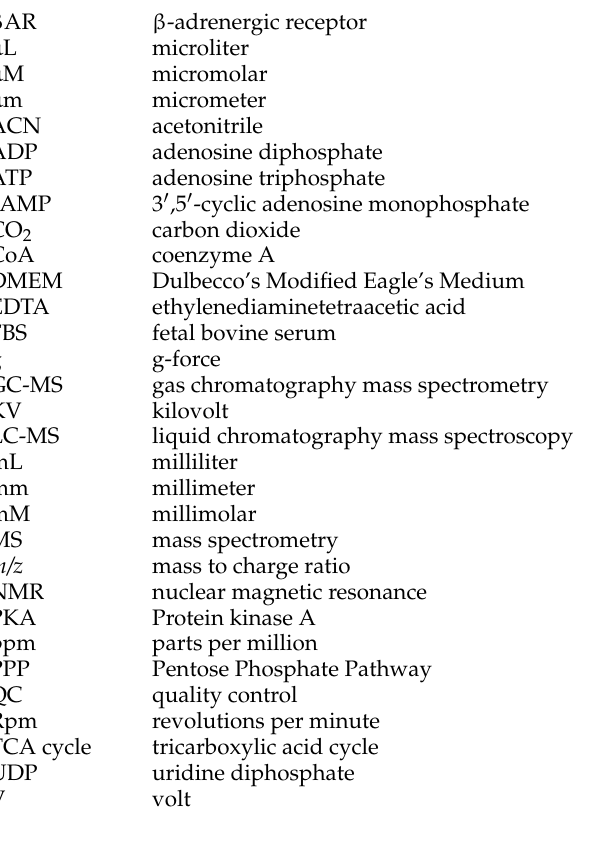
Figure S1: Principal components analysis scores plot for the first two principal components from untargeted metabolomics analysis of MDA-MB-231 cells treated for 4 h with isoproterenol (Iso), propranolol (Prop), combination of isoproterenol and propranolol (Prop + Iso) or untreated control cells (control). Values in parenthesis indicate the percentage of variance explained by each principal component, Table S1: Glucose Labelling, Table S2: Glutamine